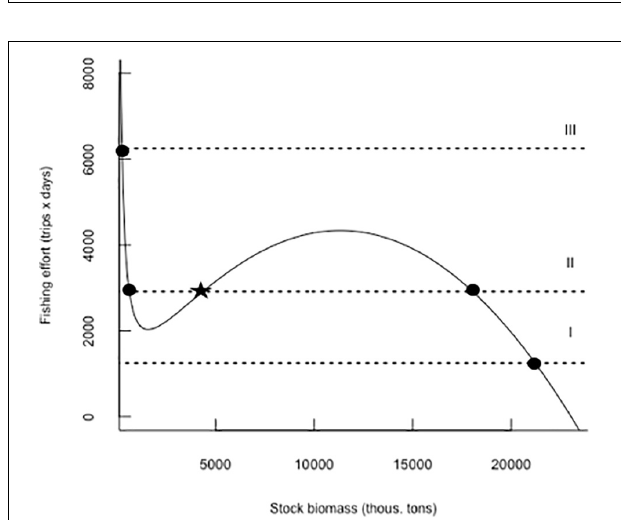
FIGURE 5 | Equilibrium isoclines from model 1 ( Table 2 ) for fish stock (solid line) and model 1 for fishing effort dynamics ( Table 2 ), the system can be stabilized toward a high fish biomass equilibrium (Isocline I), but increases in harvest or fish prices can lead the system rapidly toward a low fish biomass equilibrium with complex oscillatory transient dynamics (Isocline II) (Berryman, 1999). Closed dots are stable equilibrium points and the star represents an unstable equilibrium